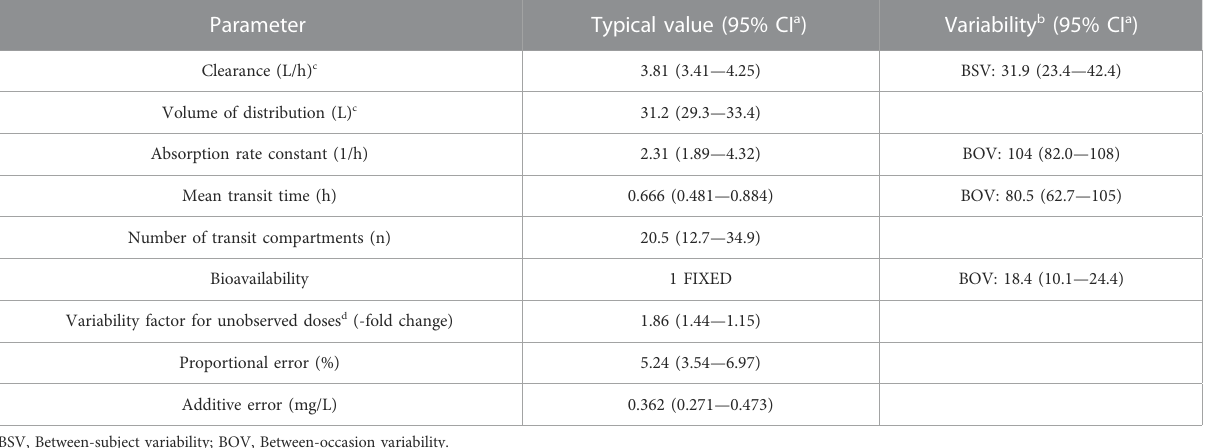
TABLE 2 Final population pharmacokinetic parameters.